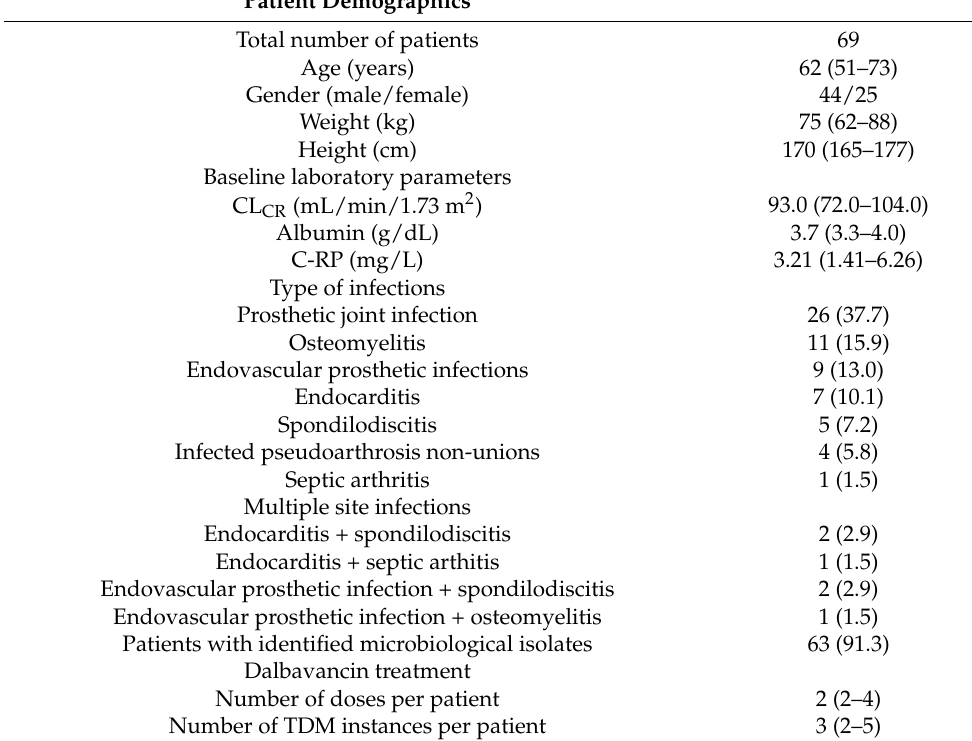
Table 1. Population characteristics.